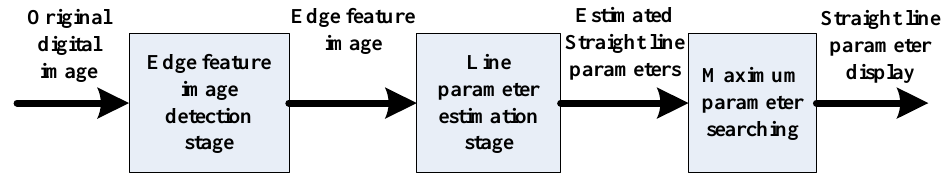
Figure 1. PHT straight line detection algorithm flow.